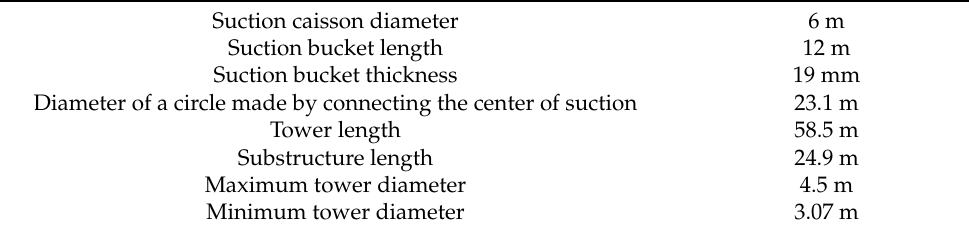
Figure 1. OWT system comprising the OWT structure and soil. ( a ) OWT components; ( b ) 3D FEM mesh model. Table 1. OWT model dimensions.